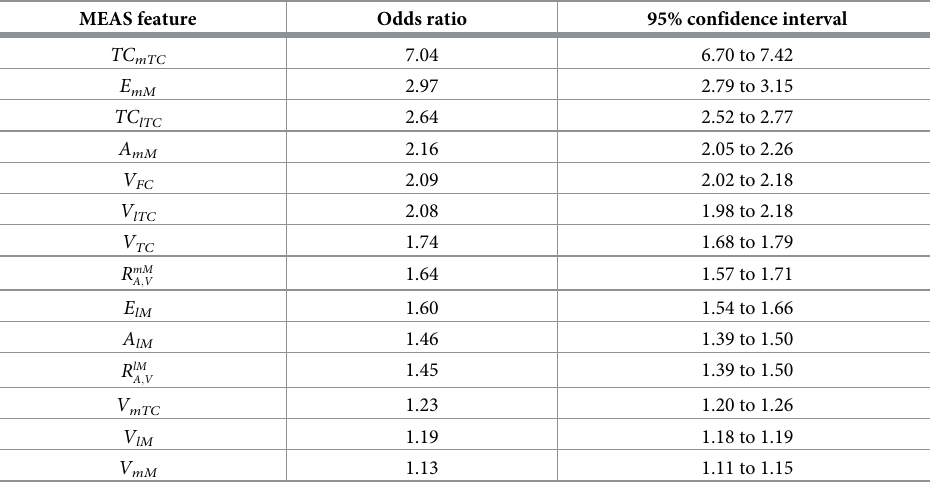
Table 6. TKR prediction via logistic regression using MEAS features. The odds ratios are provided for each feature. MEAS